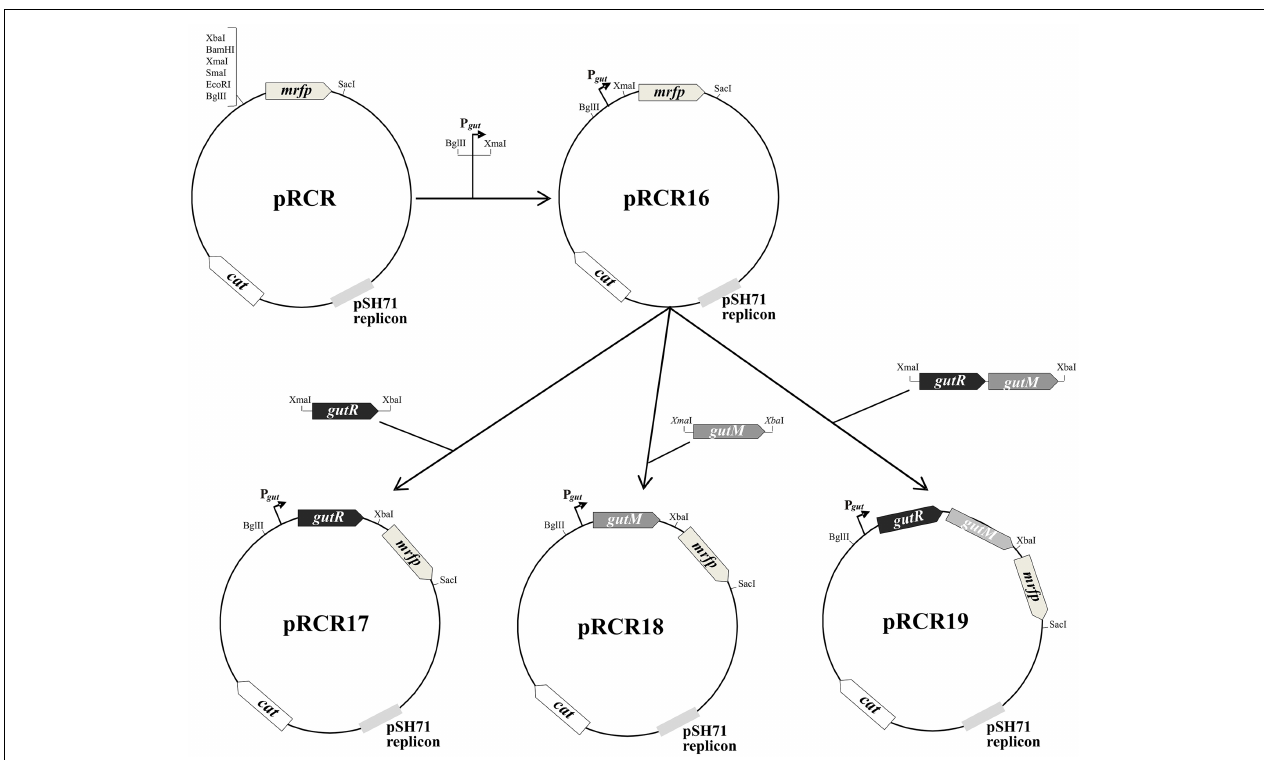
FIGURE 1 | Scheme of construction of plasmids pRCR16, pRCR17, pRCR18, and pRCR19. Maps of these plasmids and of the parental pRCR are depicted. The pertinent restriction sites are shown, as well as the putative promoter of the gut operon (P gut ) and the following genes: mrfp, cat , gutR and gutM encoding the mCherry, a chloramphenicol acetyltransferase, GutR and GutM, respectively.